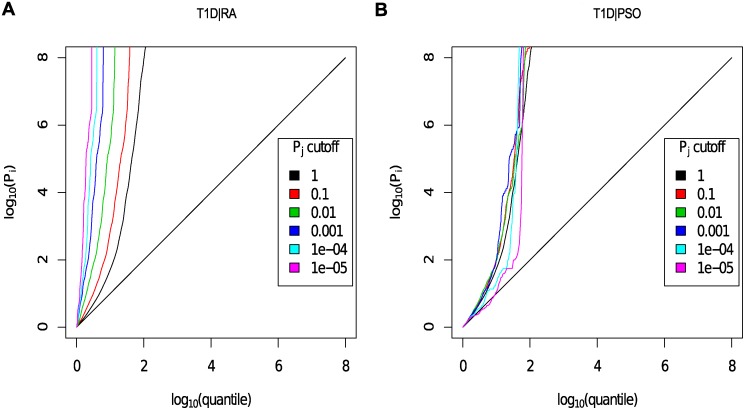
Q-Q plots for T1D conditional on RA (Panel A) and PSO (Panel B).Y axes show log10(pT1D′); X axes show log quantile (rank) of p values in various sets of SNPs. The degree of leftward shift of a black point from the diagonal is proportional to the unconditional FDR of that p value for the principal phenotype, and the degree of leftward shift of a coloured point is proportional to the conditional FDR of the p value for the principal phenotype and the p-cutoff corresponding to the colour for the conditional phenotype. As expected, a leftward shift is seen even for the unconditional Q-Q plots (black line) owing to the use of the ImmunoChip, which focuses on potential autoimmune-associated regions. Each colour corresponds to the Q-Q plot for p
T1D amongst a subset of SNPs with p
RA or p
PSO less than the indicated cutoff. P values for T1D are adjusted for the effect of shared controls between studies. A leftward shift with decreasing p
RA or p
PSO cutoff indicates that SNPs which are associated with the conditional phenotype (RA or PSO) are more likely to be associated with the principal phenotype (T1D), presumably due to pleiotropic effects on phenotypes. Good enrichment is seen for T1D conditioning on RA (Panel A), and little or no enrichment conditioning on PSO (Panel B).